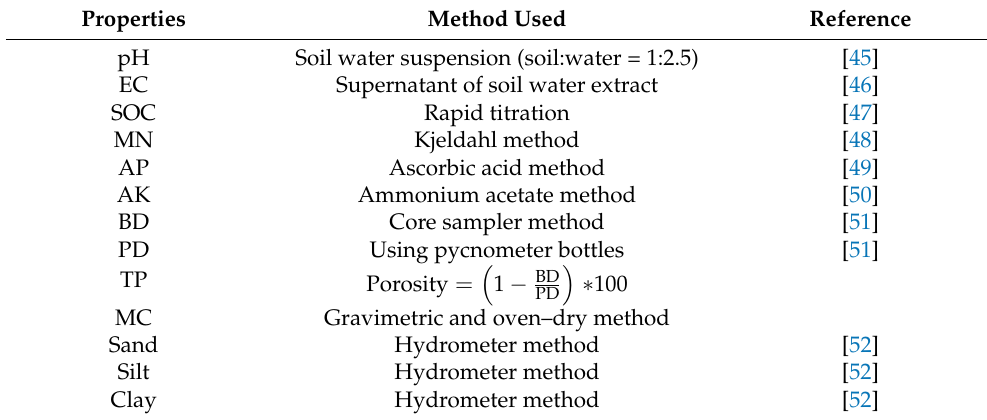
Table 2. Methods used for the analysis of selected properties of soil in the present study.